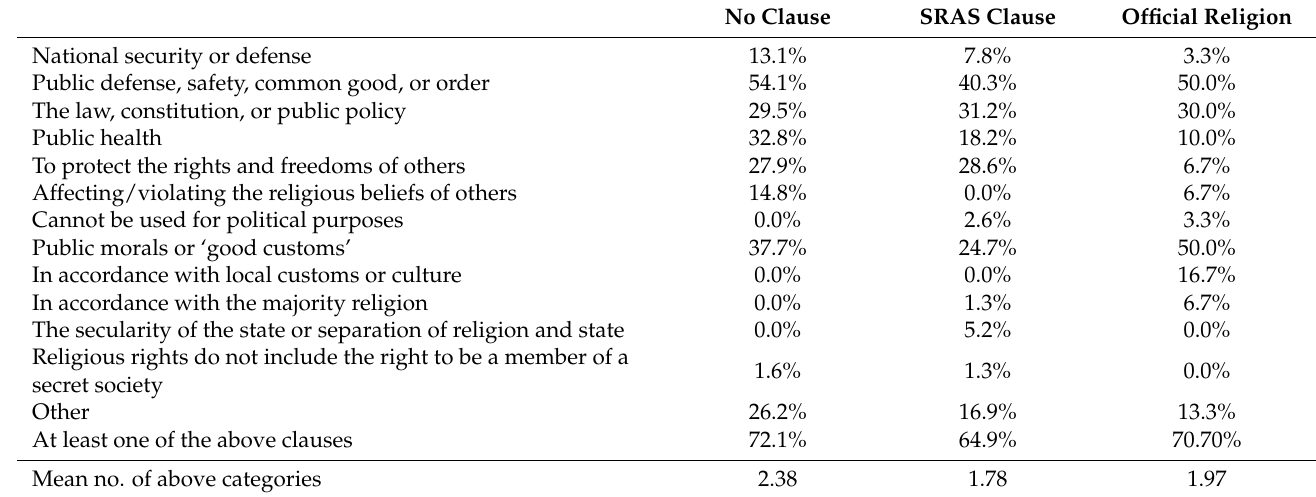
Table 10. Qualifications on religious freedom (among countries with religious freedom